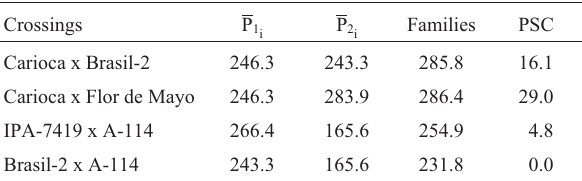
Table V - Mean grain yield (g/plot) of the parents (P lies from each i th population and percentage of families superior to the